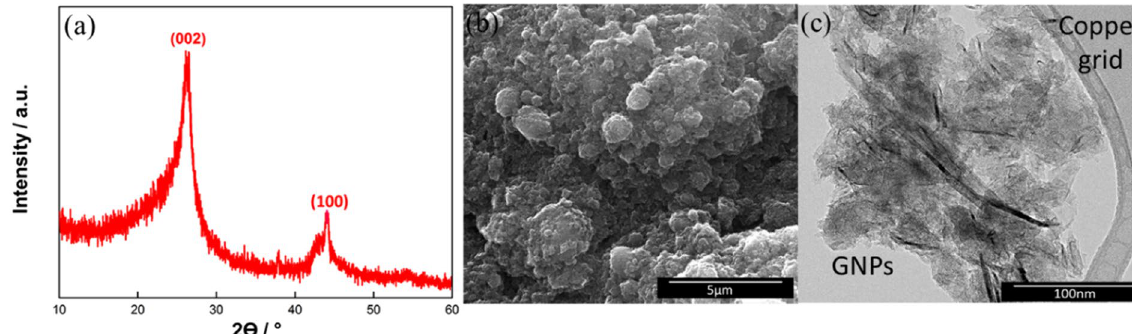
Figure 1. ( a ) XRD ( b ) FESEM, and ( c ) TEM images of